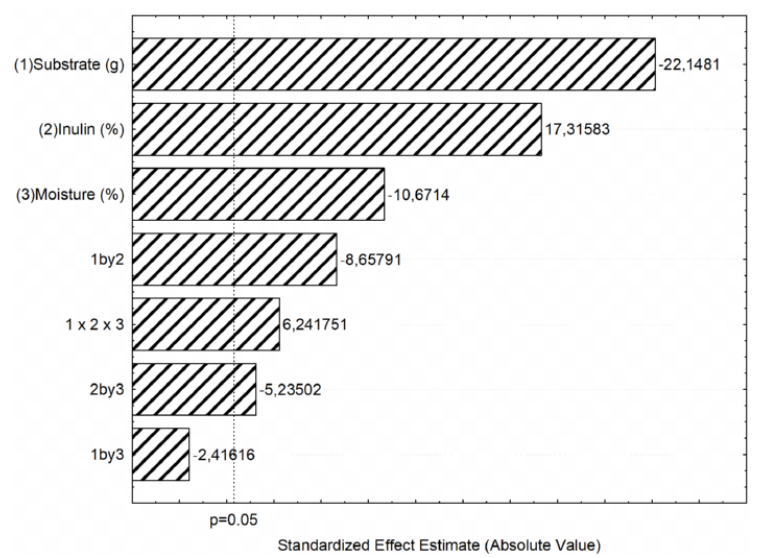
Figure 1. Pareto chart of the standardized effects of substrate amount, inulin concentration, and moisture content on inulinase production by Aspergillus terreus URM4658 in solid-state fermentation using wheat bran as a substrate.